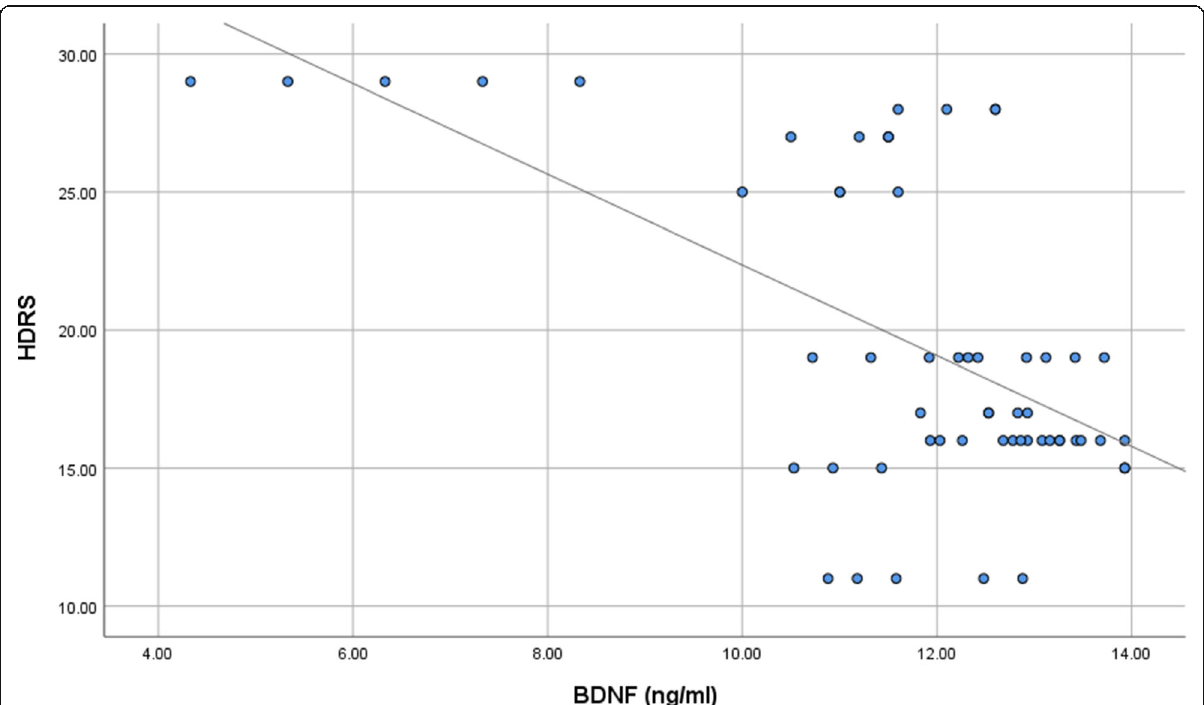
Fig. 2 Correlation between serum level of brain-derived neurotrophic factor (BDNF) and Hamilton Depression Rating Scale (HDRS)